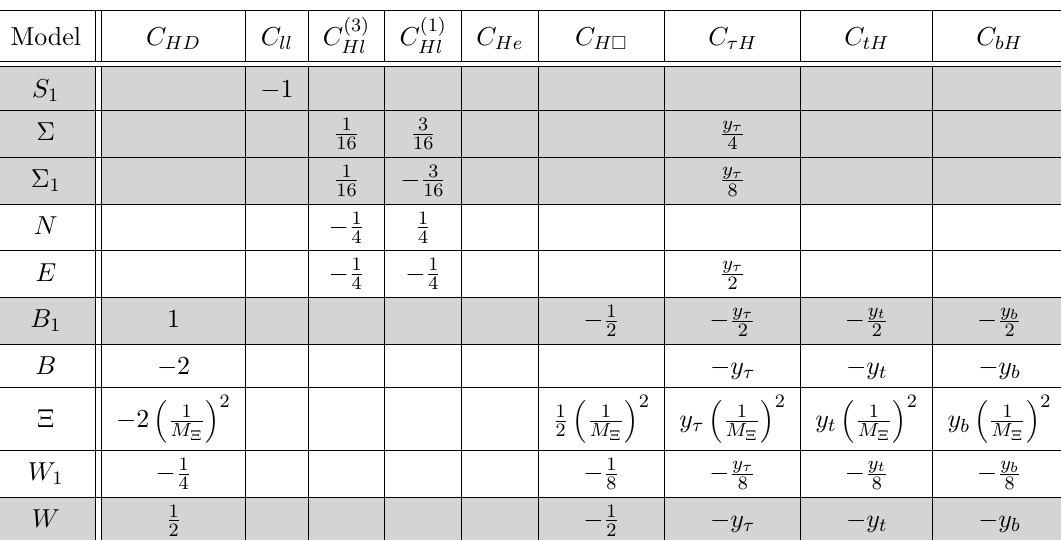
Table 3 . Operators generated at the tree level by the single-field extensions listed in the first column, which can make tree-level contributions to m W . The coefficients of the operators are given by the squares of the corresponding coupling divided by the corresponding M 2 , with the exception of an extra factor of 1 /m 2 in the case of the Ξ field, as noted in the table. We denote the top, Ξ bottom and τ Yukawa couplings by y t , y b and y τ , respectively. Models that contribute to m W in such a way that they cannot improve upon the SM fit are greyed